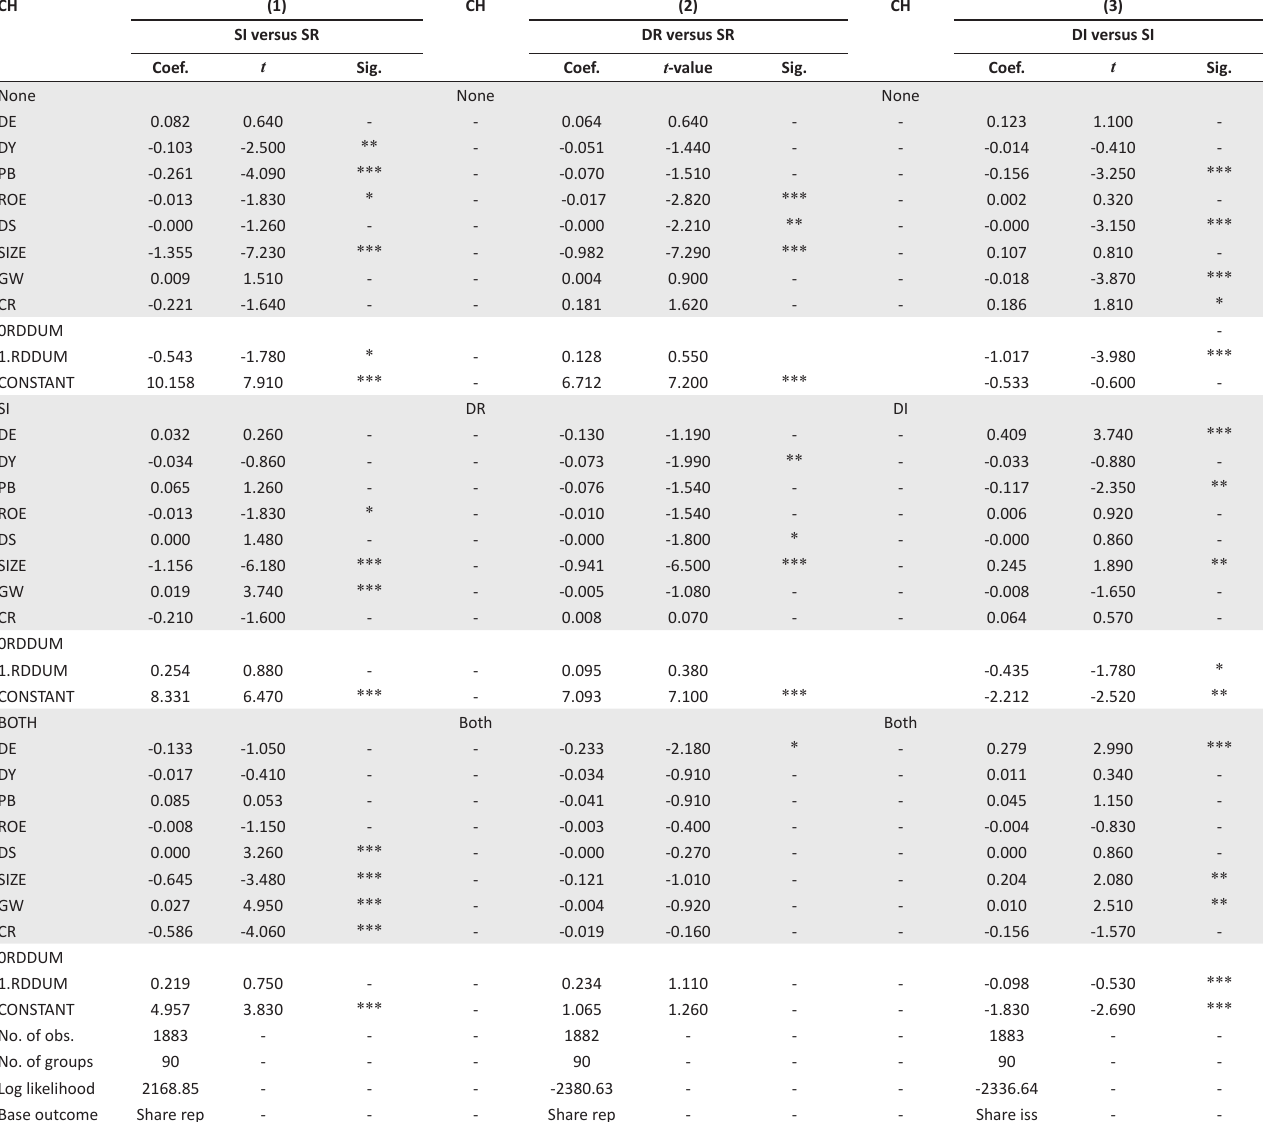
TABLE 5: Determinants of choice between share issues versus share repurchases, debt repayments versus share repurchases and debt issues versus share issues.